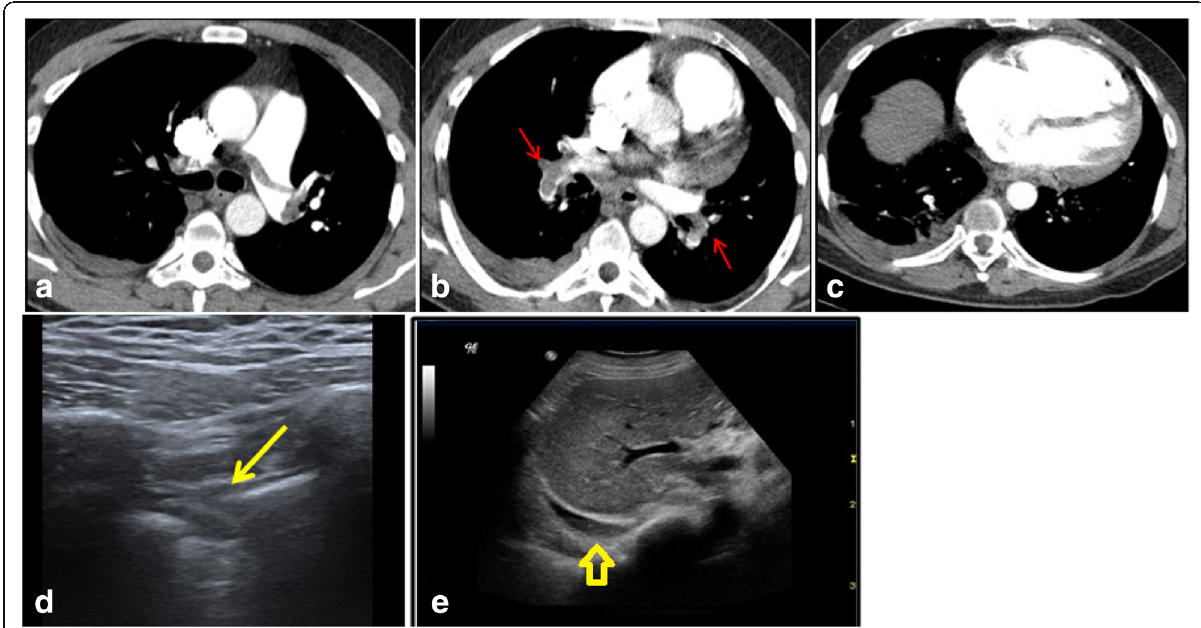
Fig. 3 a – c CT pulmonary angiography shown in axial sections in the mediastinal window demonstrating a , b a saddle-shaped embolus extending from the distal pulmonary artery bifurcation to the right and the left main pulmonary branches then into the upper and lower segmental and subsegmental divisions ( red arrows ). c A mild right pleural effusion and multiple pleural-based subsegmental atelectasis were detected. d , e Ultrasound images in B-mode for the same patient showing a right basal hypoechoic pleural-based lesion ( yellow arrow ) in d ; coexistent right basal mild reactive simple pleural effusion was seen ( open yellow arrow ) in